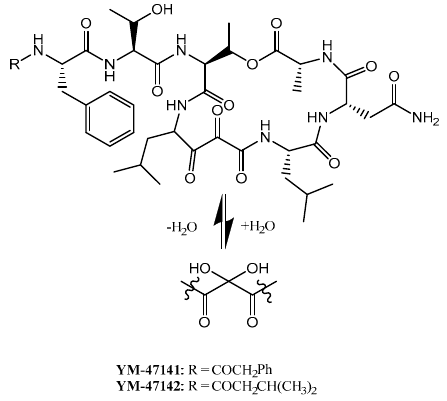
Figure 11. Structures of YM-47141 and YM-47142.